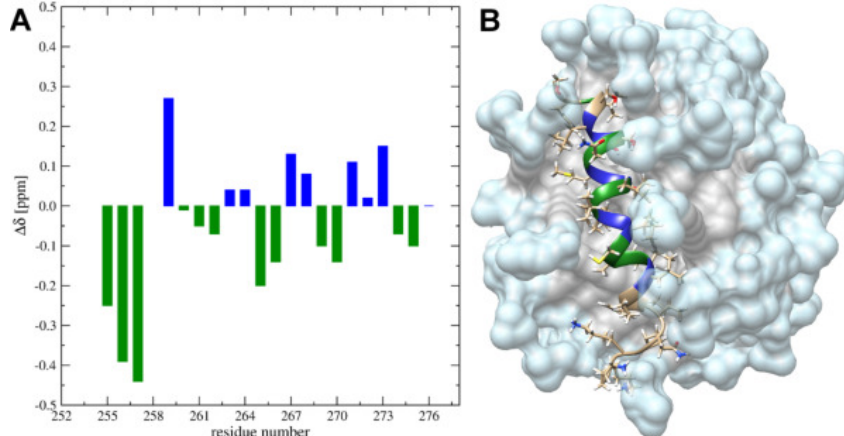
Figure 3. ( A ) CSP (chemical shift perturbation) plot for the amide ( 1 H N ) protons obtained for SDS- d 25 and DPC- d 38 media. ( B ) The 3D structure of the TM4 fragment in the DPC- d 38 micelle. Residues demonstrated upfield and downfield shifts of the 1 H N resonances in DPC- d 38 micelle compare to SDS- d 25 are highlighted as blue and green, respectively.